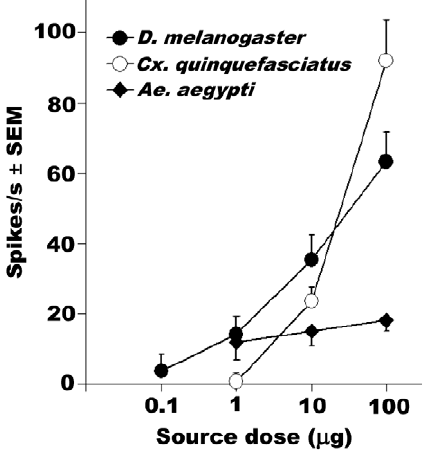
Figure 4. Excitatory responses from an ORN housed in the maxillary palp basiconic sensillum pb1A when challenged with three insect repellents: DEET, IR3535 and picaridin. Two types of neurons, A and B, are identified on the basis of their spike amplitudes. The ORN with larger amplitude, A, is stimulated by the three insect repellents, whereas the neuron with smaller amplitude, B, was unresponsive. Source dose, 100 m g.